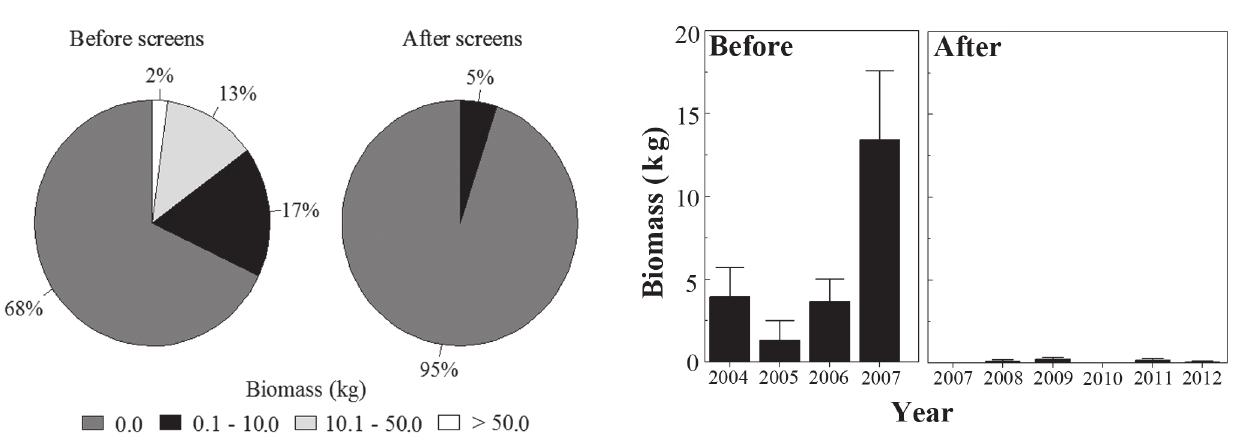
Fig. 4. Frequency in occurrence of dead/moribund fish biomass per turbine stop/startup before (left) and after (right) the use of fish screens at Três Marias Dam.